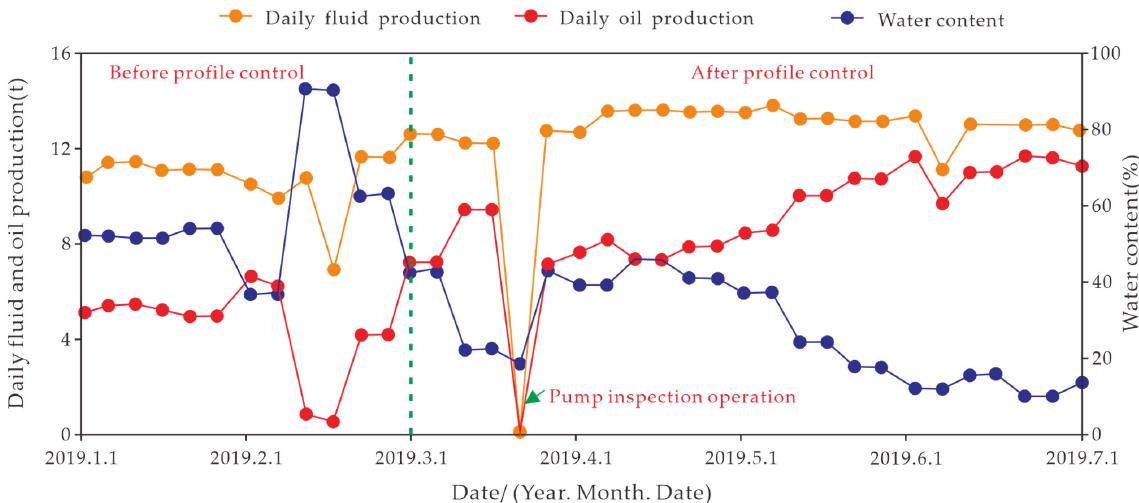
Figure 13. Oil production rate curve of the Q12H13 − 9 well in the Qie12